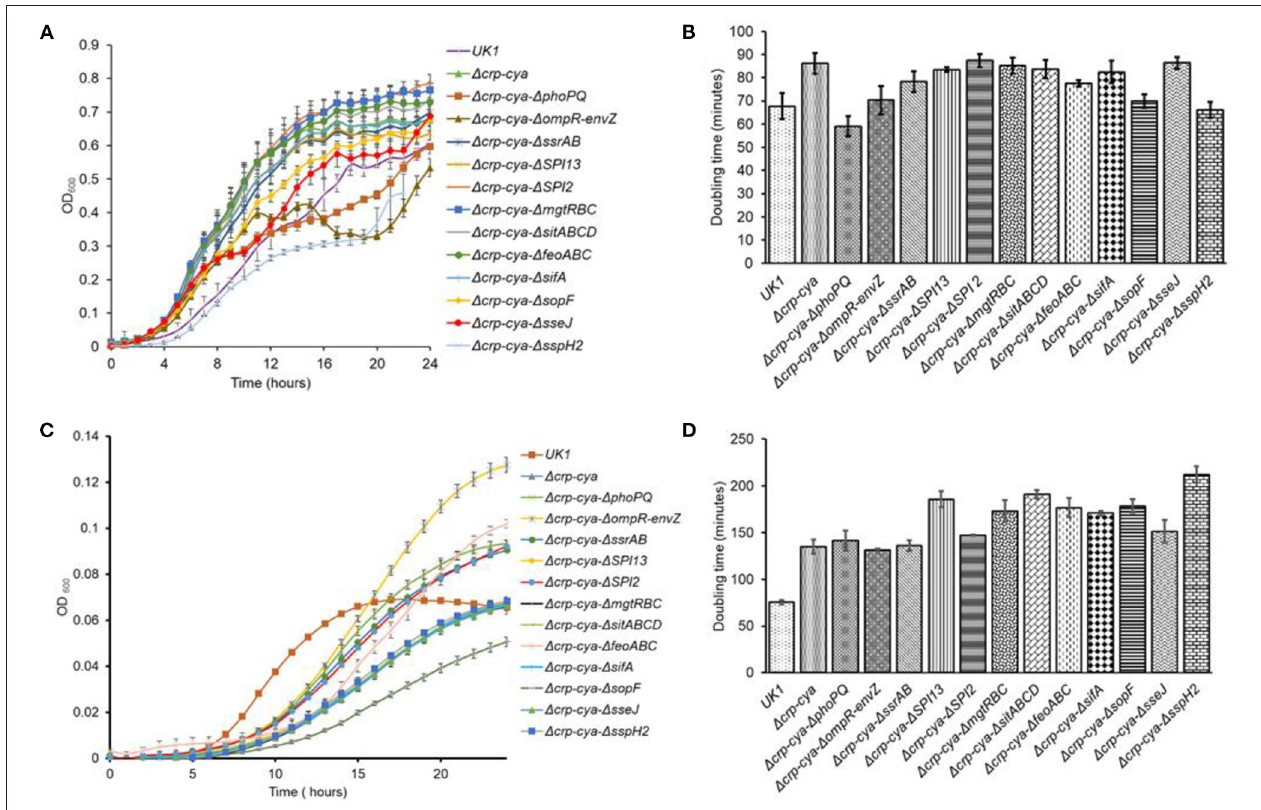
FIGURE 4 | In vitro growth characteristics of S. Typhimurium UK1, 1 crp - cya and its derivatives in defined and SCV-simulating media. ( A,B) . Growth curves and doubling times of S. Typhimurium UK1, 1 crp - cya and its derivatives in M9 medium supplemented with 0.1% glucose and 0.12% casamino acids. (C) and (D) . Growth curves and doubling times of S. Typhimurium UK1, 1 crp - cya and its derivatives in PCN media.